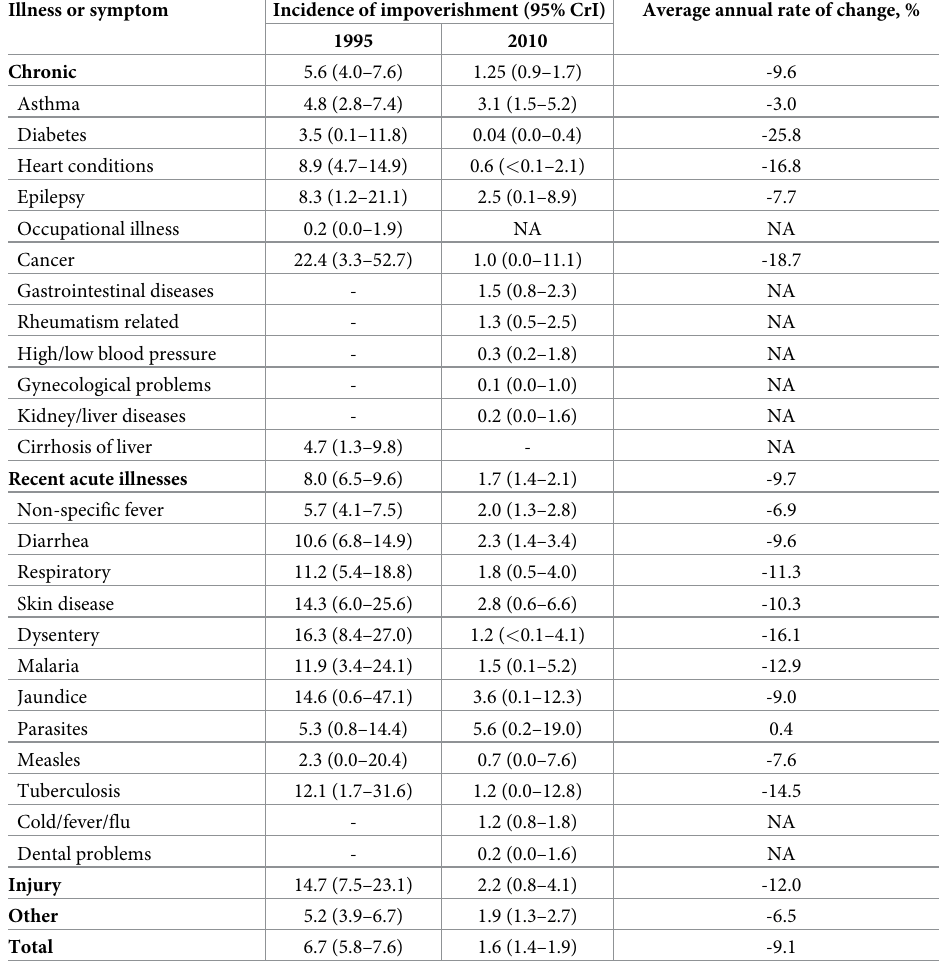
Table 6. Disease-specific impoverishment due to healthcare payment in Nepal